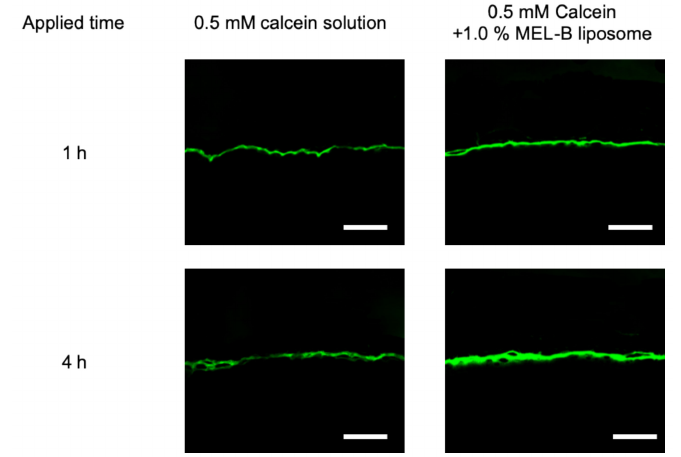
Figure 4. Confocal laser scanning microscopy images of a cross-section of the intact skin of a hairless mouse after the application of calcein aqueous solution or MEL-B liposomes containing calcein. The bar indicates 50 µ